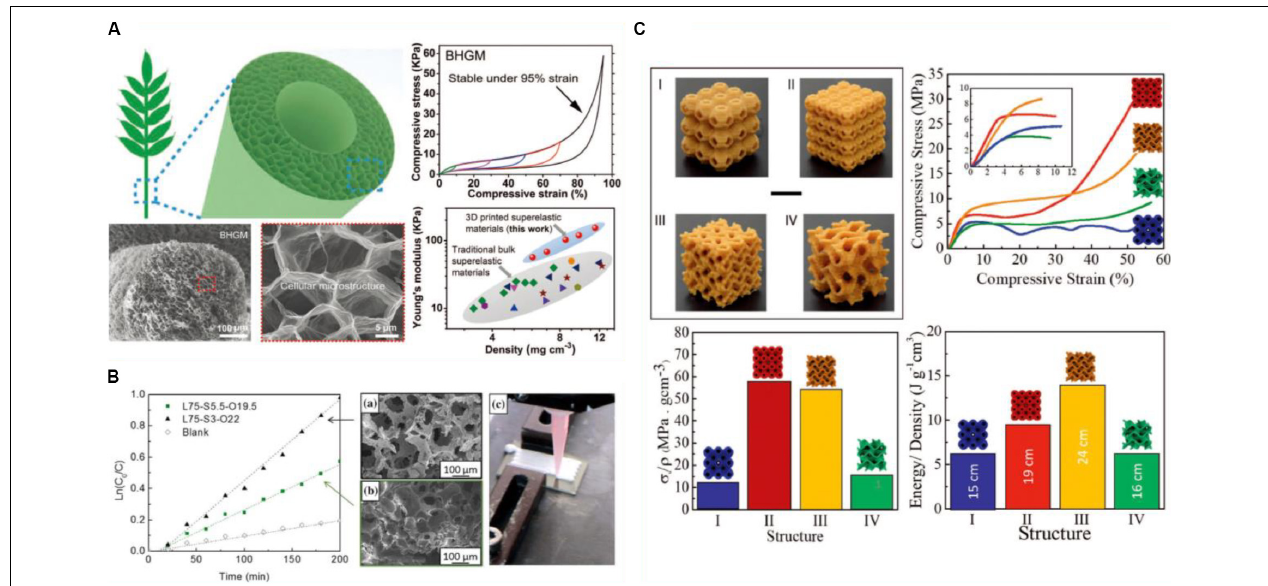
FIGURE 3 | (A) Hierarchical and cellular graphene materials inspired by the grass stem of Elytrigia repens, via 3D printing (Peng et al., 2019). Reproduced with the permission of 2019 WILEY-VCH Verlag GmbH & Co. KGaA, Weinheim. (B) TiO2 foams with hierarchical cellular structure, fabricated by 3D printing (Arango et al., 2018). Reproduced with the permission of 2018 The Minerals, Metals & Materials Society. (C) 3D printed schwarzite structures across different length scales (Sajadi et al., 2018). Reproduced with the permission of 2017 WILEY-VCH Verlag GmbH & Co. KGaA, Weinheim.